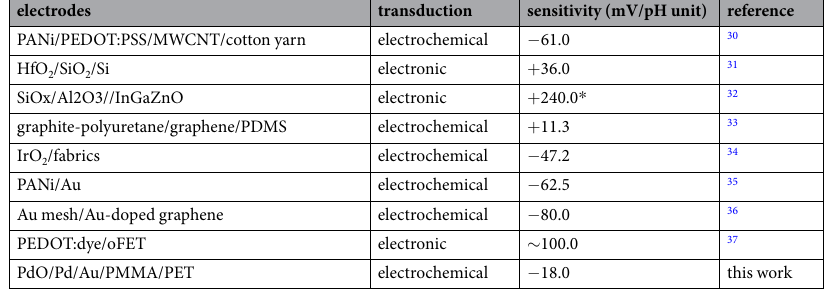
Table 3. Comparison of the performance of some pH-sensors sensors reported in literature after 2016. * At 100 accumulation cycles; PANi - polyaniline; PEDOT:PSS - poly(3,4-ethylenedioxythiophene) polystyrene sulfonate; oFET - organic field effect